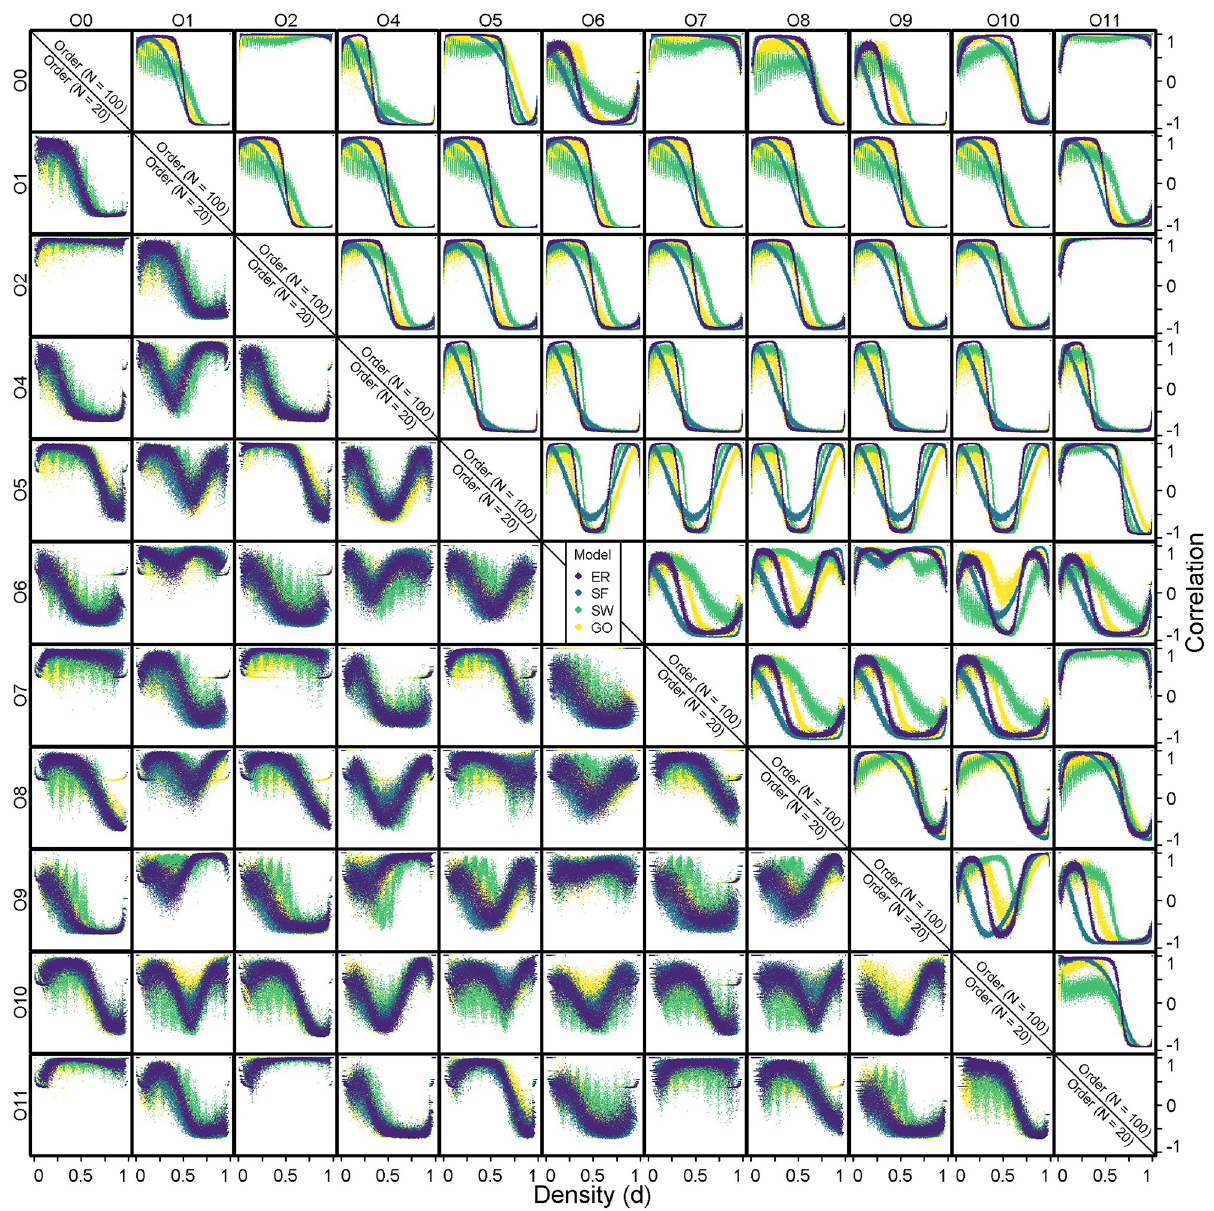
Fig 2. Evolution of the 55 graphlet correlation coefficients. Erd ő s-Re´nyi ( ER , in dark purple), Fitness Scale-Free ( SF , in blue), Watts-Strogatz small- world ( SW , in green) and Geometric ( GO , in yellow) models. For two different order values N = 20 (lower triangle figures) and N = 100 (upper triangle figures), the graphlet correlation coefficients are computed for 100 graphs of the four models and for edges densities ranging from 0 to 1.